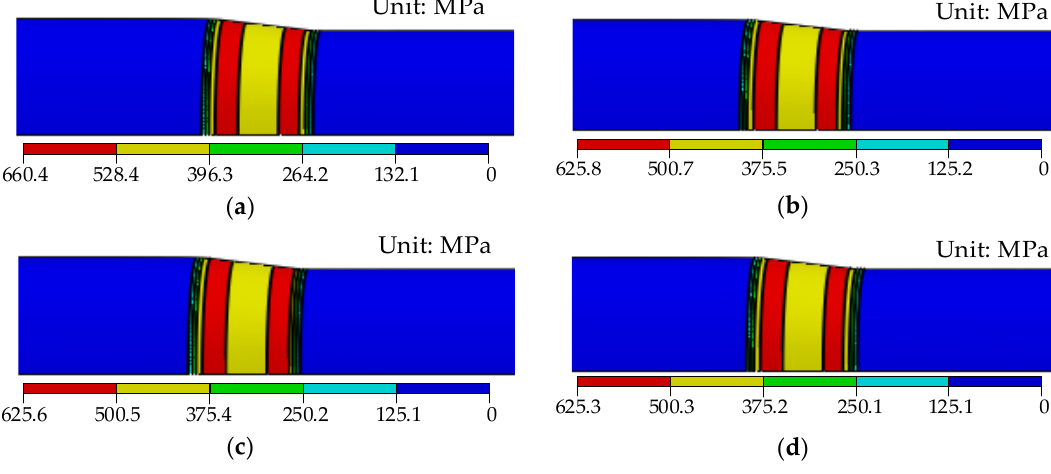
Figure 16. Contact stress distribution at contact interface under ultrasonic drawing conditions when the die locates 15.8 mm from the reel and in various motion states: ( a ) Equilibrium position and moves to left; ( b ) Left extreme position; ( c ) Equilibrium position and moves to the right; ( d ) Right extreme position.